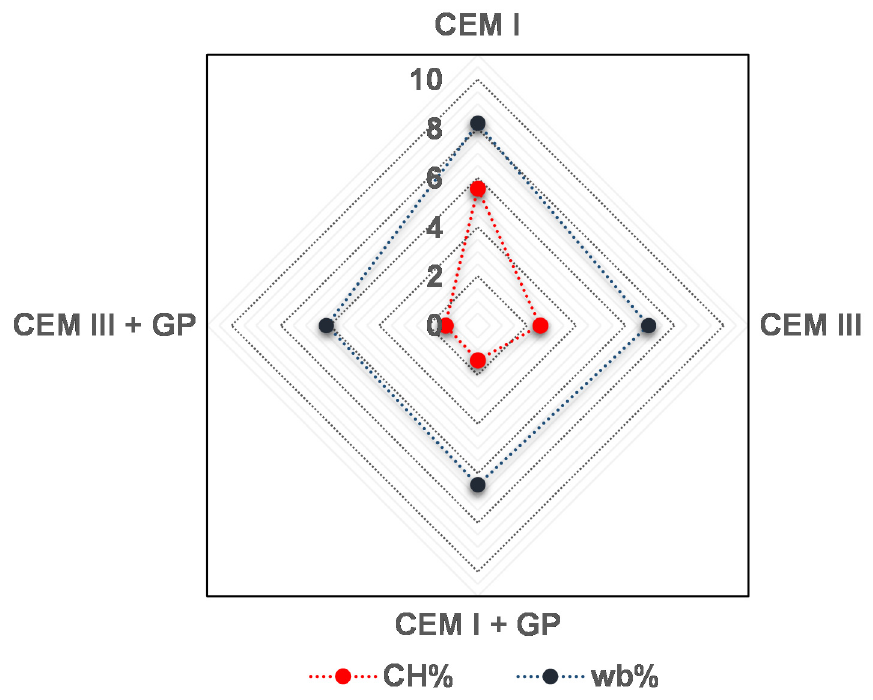
Figure 11. CH% and w b % of mortars